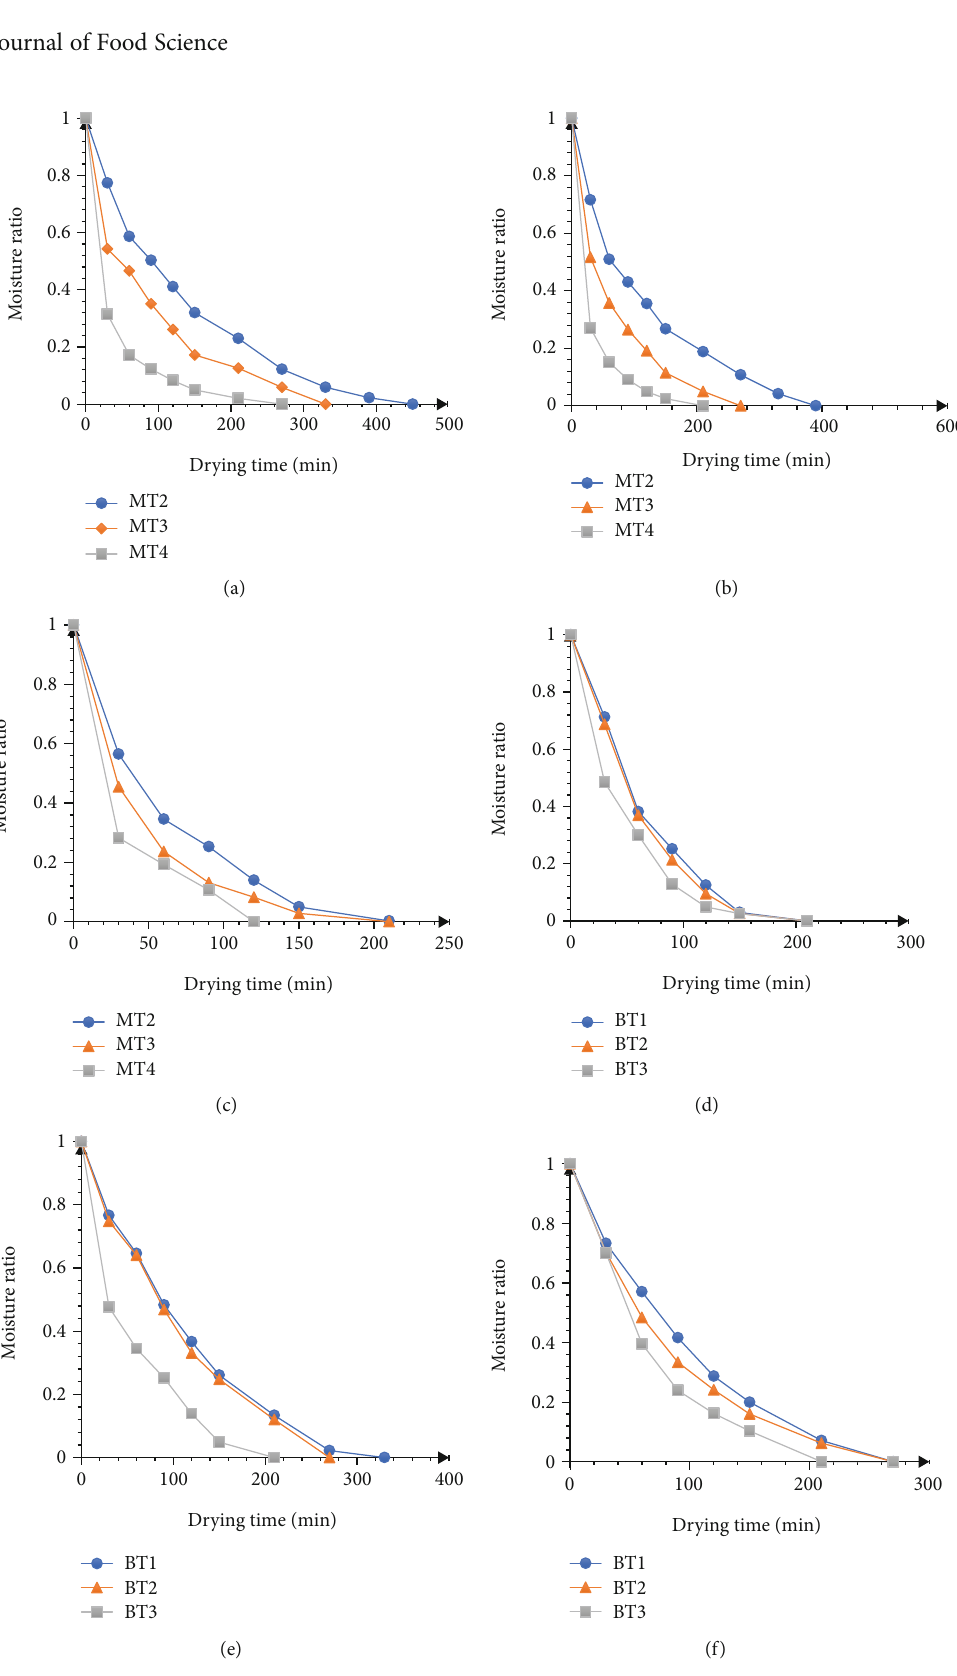
Figure 1: Variation of moisture ratio versus drying time for microwave-assisted drying (a) 385 W, (b) 541W, and (c) 697W and blanch- assisted drying (d) 3mm, (e) 6mm, and (f) 9mm at 70 °